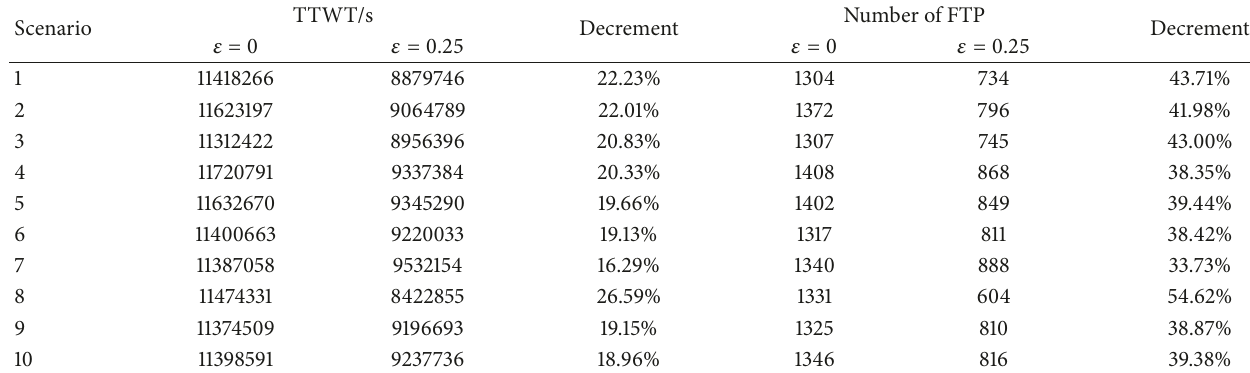
Table 3: Solution results of different